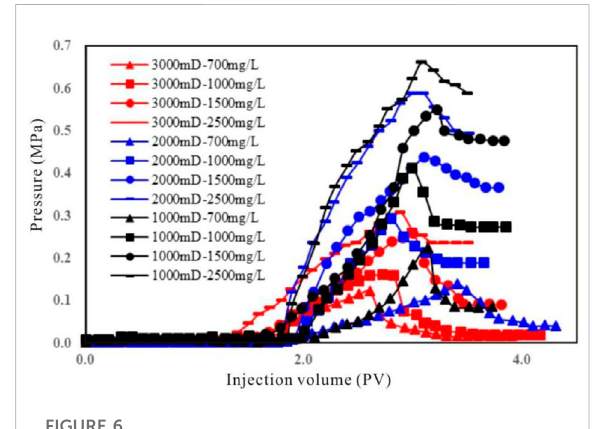
FIGURE 6 Water displacement pressure curves of core